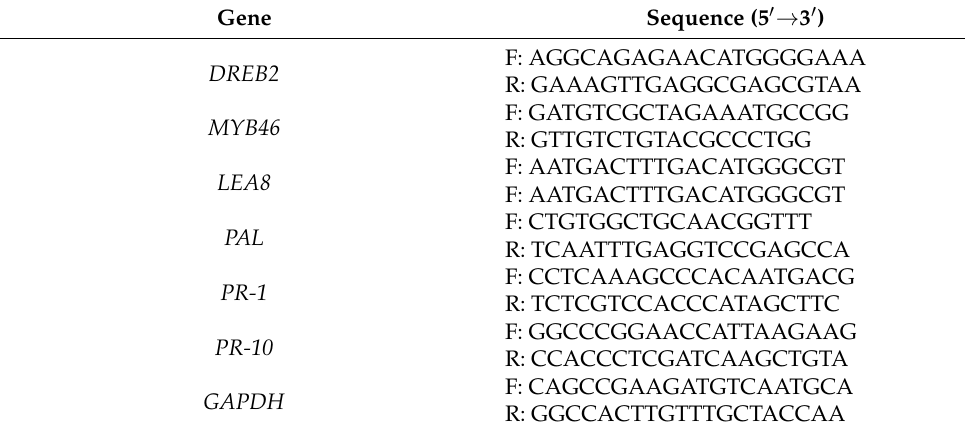
Table 1. Primer sequences for the stress resistance